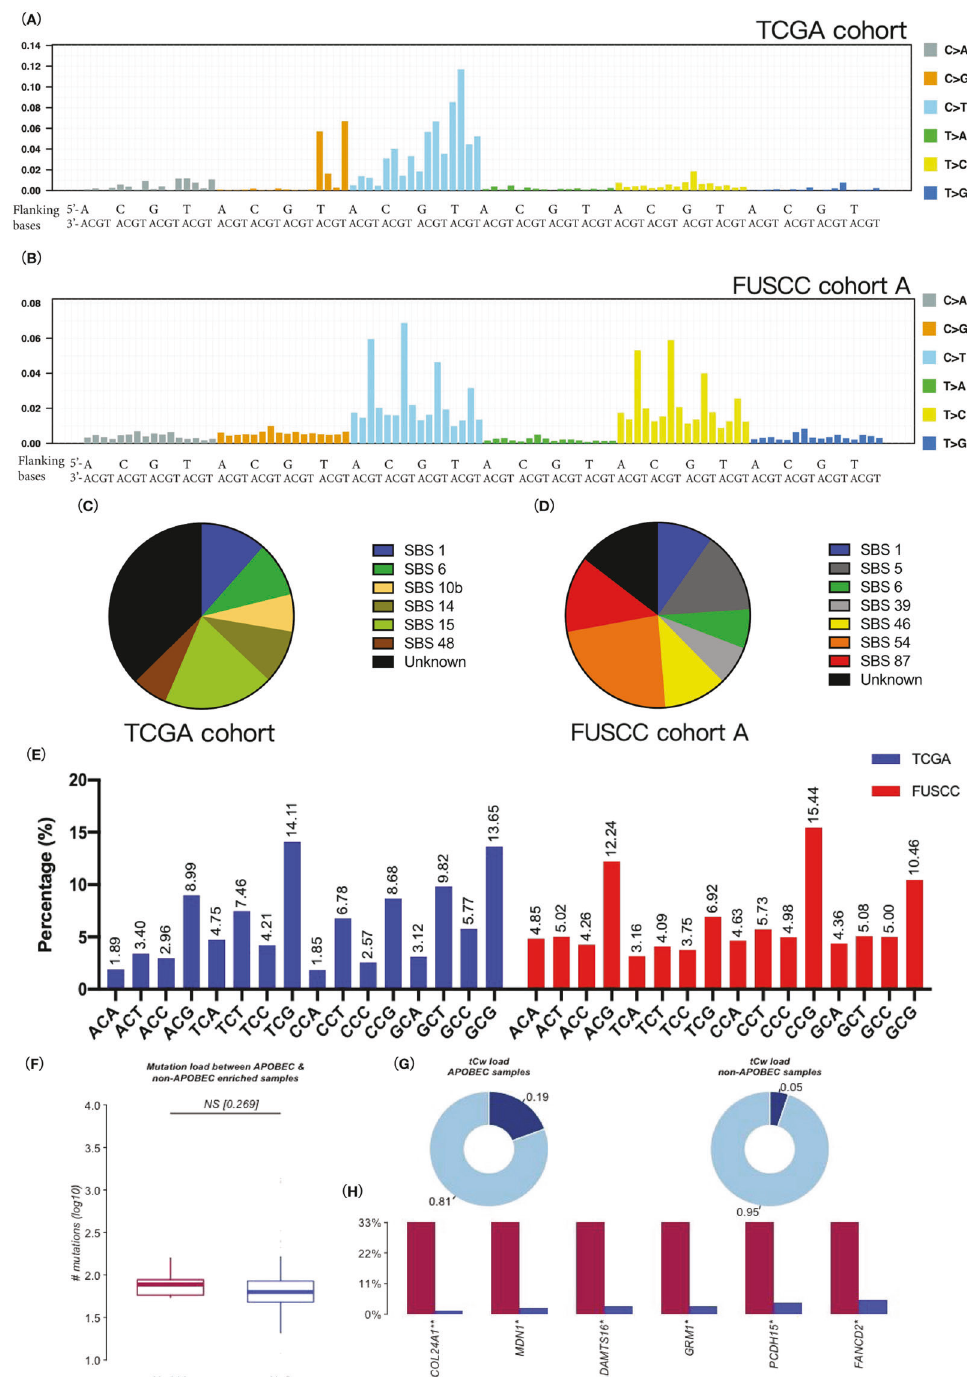
Fig. 1 Mutational signatures and SNV distribution in the PDAC genome. A , B Mutational signatures deconstructed from TCGA PDAC cohort ( A ) and FUSCC PDAC cohort A ( B ). The upper x -axis represents the nucleotide in the 5 ’ end fl anking the SNVs, and the lower x -axis represents the nucleotide in the 3 ’ end fl anking the SNVs. C , D Comparison between the deconstructed mutational signatures and validated SBS signatures (v3.2, March 2021). In TCGA cohort ( C ), the SBS1 weight was 0.115, SBS6 and SBS15 weights were 0.0955 and 0.193, respectively, SBS10b weight was 0.0649, and SBS14 weight was 0.0935. SBS48 correlated with potential artefacts and its weight was 0.0618. In FUSCC cohort A ( D ), the SBS1 weight was 0.0975, SBS5 and SBS39 weights were 0.142 and 0.068, respectively, SBS6 weight was 0.0685, and SBS87 weight was 0.133. SBS46 and SBS54 correlated with potential artefacts and their weights were 0.111 and 0.234, respectively. E Summary of trinucleotide motifs of all C > X mutations in TCGA cohort and FUSCC cohort A. F , G , H APOBEC-enriched samples referred to those samples with an enrichment score E-TCA > 2. The comparison between non-APOBEC-enriched samples (TCGA PDAC cohort, n = 141) and APOBEC- enriched samples ( n = 6) was performed using the “ plotApobecDiff ” function of the maftools R package, including comparisons of the mutation burden ( G ), tCw burden ( H ) and differentially altered genes ( I ). Detailed information was shown in Table S2. SNV, single-nucleotide variant; PDAC, pancreatic ductal adenocarcinoma; SBS, single-base substitution; tCw, w = A or